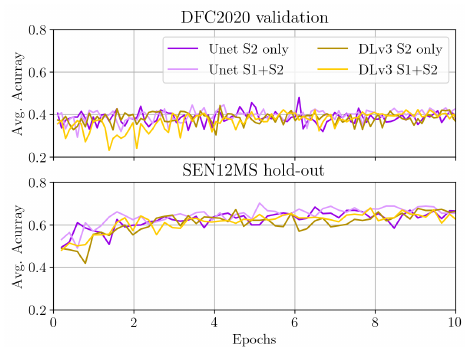
Figure 5. Comparison of the Average Accuracy metric achieved on both the DFC2020 validation as well as the SEN12MS hold-out set over the training process for the different deep semantic segmentation networks described in section